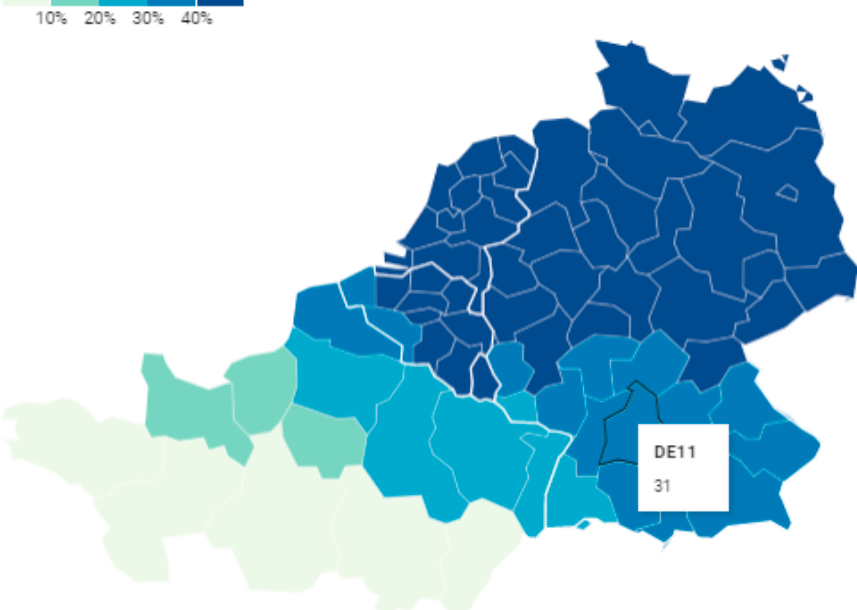
Figure 7. Reduction in external costs when using intermodal transport solutions (created with Datawrapper).